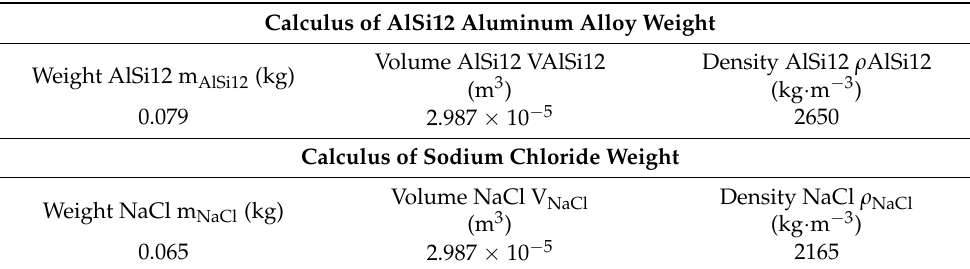
Table 3. Calculated values weight of AlSi12 alloy and sodium